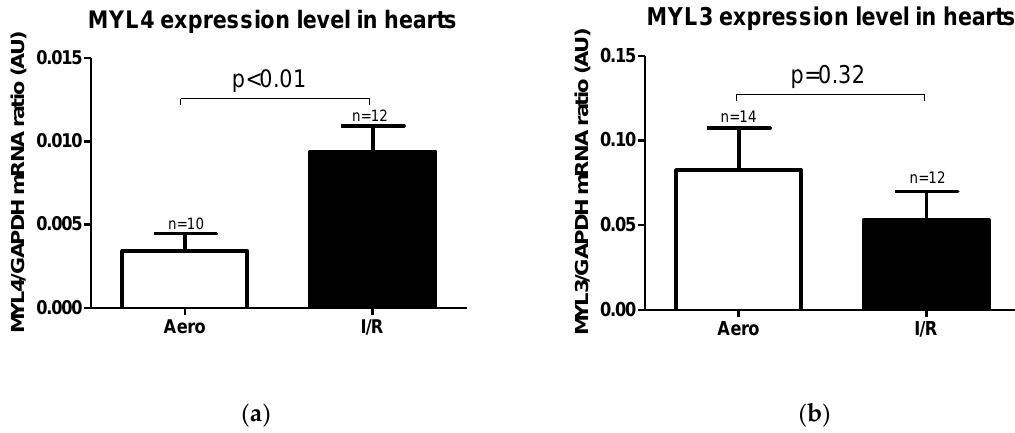
Figure 6. ( a ) Myosin light chain 4 ( MYL4 ) and ( b ) Myosin light chain 3 ( MYL3 ) mRNA expression level normalized to the GAPDH gene. GAPDH—glyceraldehyde 3-phosphate dehydrogenase; all data are expressed as mean ± SEM.